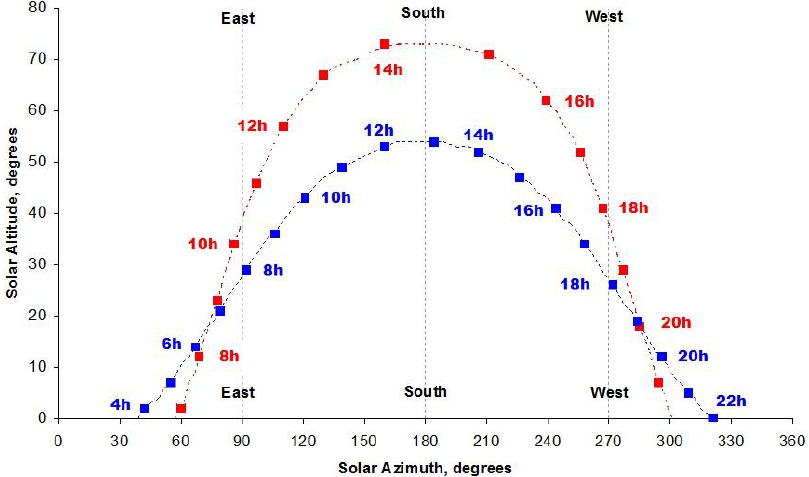
Figure 5. The sun path in Stockholm (blue) and Madrid (red) on 21 June. Time is given in local (daylight saving) time, which is 2 h ahead of GMT, and the solar azimuth angle is expressed relative to true north.